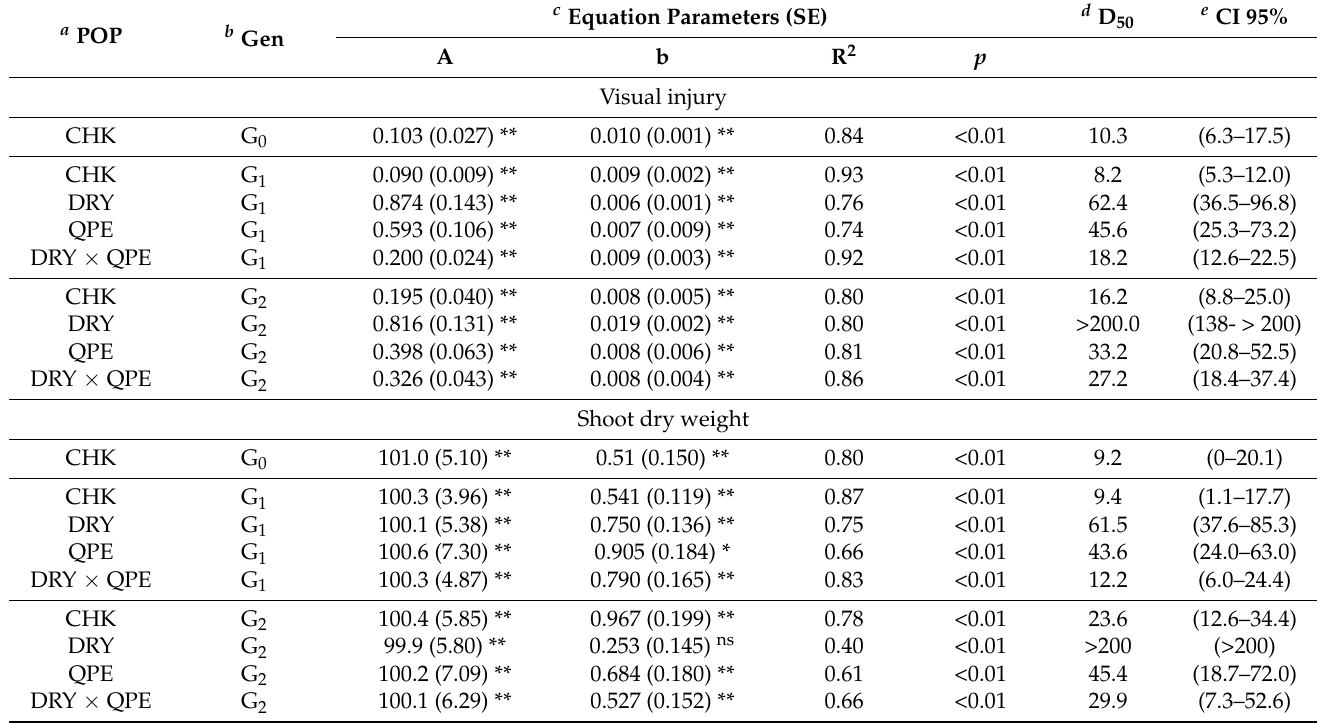
Table 2. Visual injury and shoot dry weight of Eragrostis plana populations from generations G 0 , G and G 2 at 35 DAA of quizalofop-p-ethyl doses. Equation parameters estimates a and b, 50% efficient doses (ED 50 or G 50 ) with confidence interval